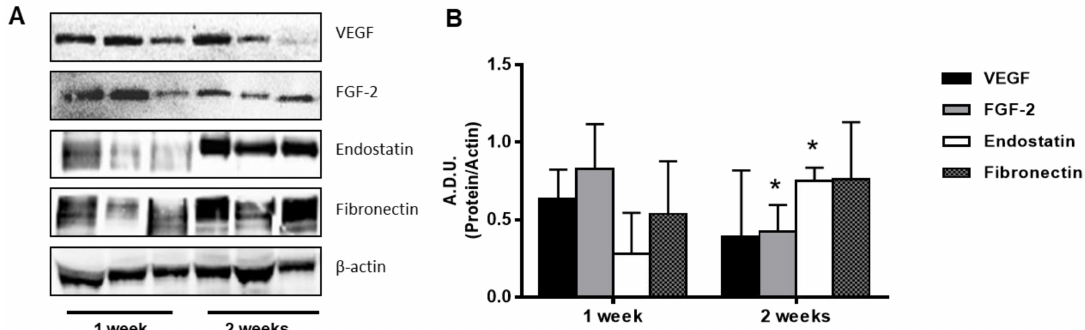
Figure 7. Western blot analysis of proteins in the subcutaneous plugs. Representative blots of samples at di ff erent times (panel A ) and quantification of the signals of interest (panel B ). Data are reported